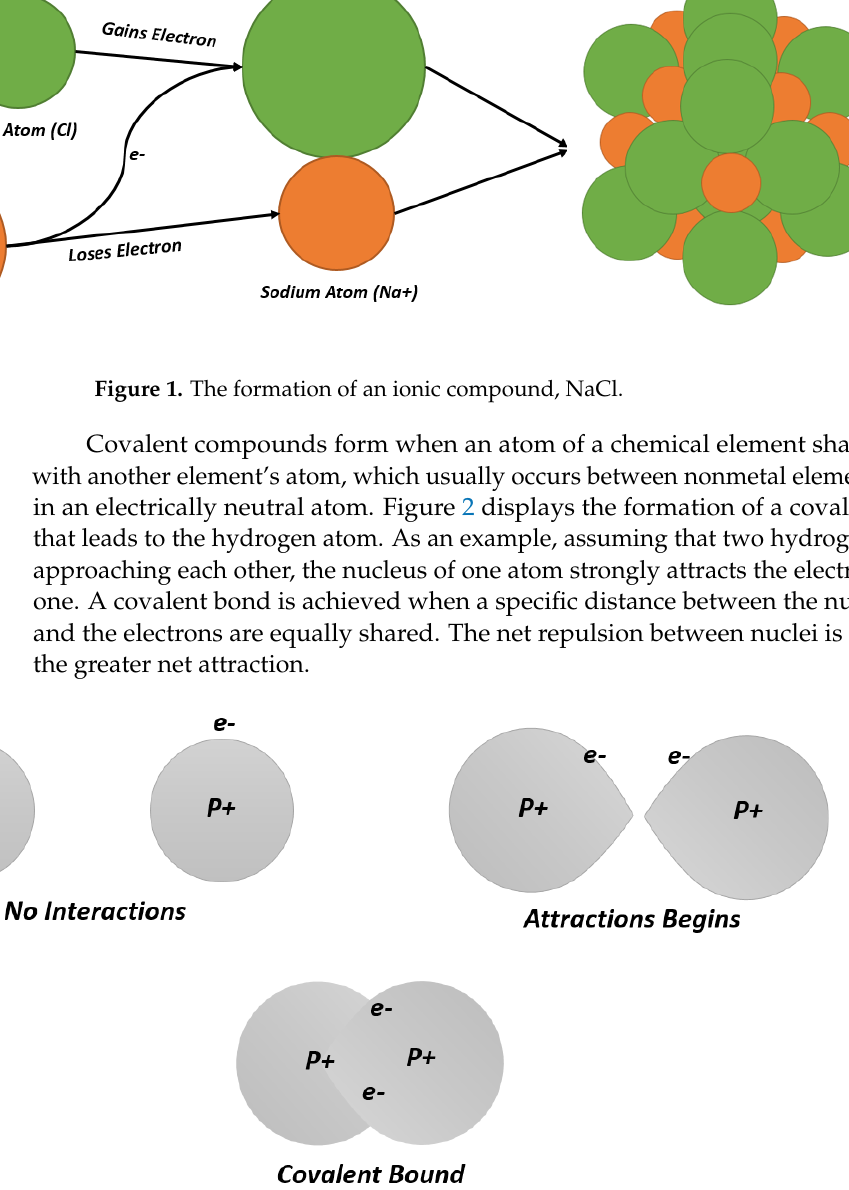
Figure 2. The formation of a covalent compound by means of two hydrogen atoms.